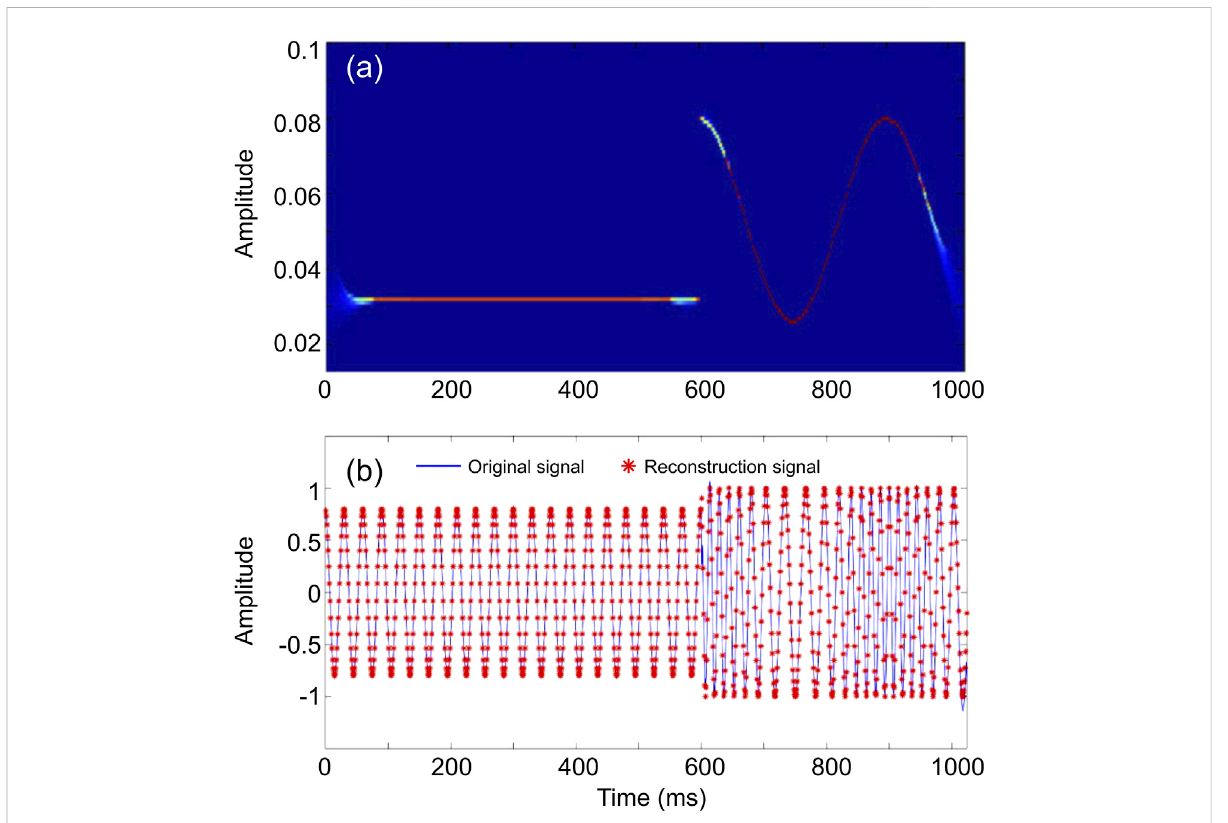
FIGURE 2 Results of theimproved synchrosqueezing transform (SST) of s (t), shown in Panel 1. (A) Results of theimproved SST for thesignal (this is plotted with MATLAB, with the “ jet ” colormap; red indicates higher amplitude); (B) comparison between the original signal and reconstructed signal by the improved SST [this is plotted with MATLAB, the blue solid line represents the original signal s (t); the red asterisk represents the reconstructed